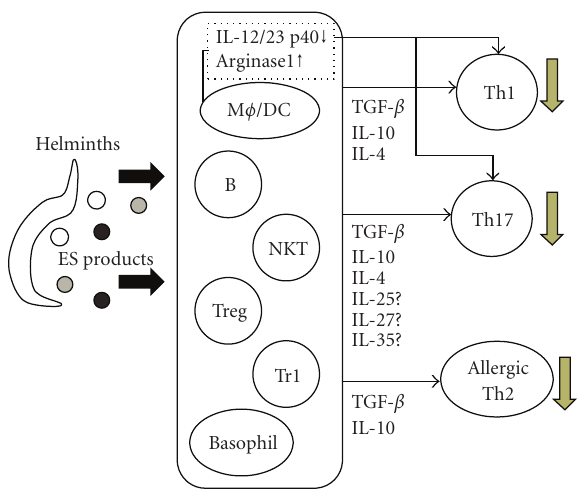
Figure 1: Possible involvement of immune cells and mediators in the helminth-induced immunomodulation on T helper subsets. Substances contained in the bodies of helminths or their excretory secretory (ES) products are recognized by innate immune cells via PAMPs receptors like TLRs. Thereafter, various changes occur in the immune cells, for example, down-modulation of IL- 12/23p40 expression (DC), alternative activation (macrophages), proliferation and/or IL-10 production (Treg, Tr1, and B cells), and IL-4 production (basophils). We can observe suppression of immune disorders with down-regulation of pathogenic T helper subsets (Th1, Th17, and allergic Th2) as consequence of mixed e ff ects of such immunological